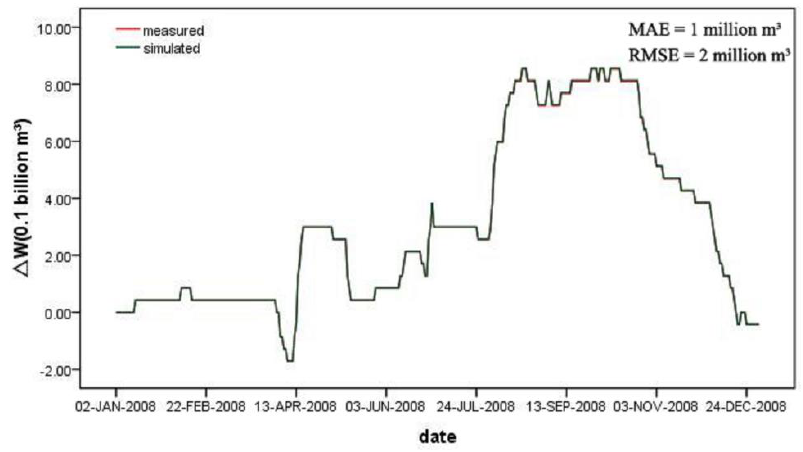
Figure 13. Seasonal variations of water volume in 2008. The green line represents the water volume variations estimated by using Equation (5) and the water level observations at the Xiashe station as inputs. The difference between the measured and simulated water volume variations is so small that these two curves almost overlap each other